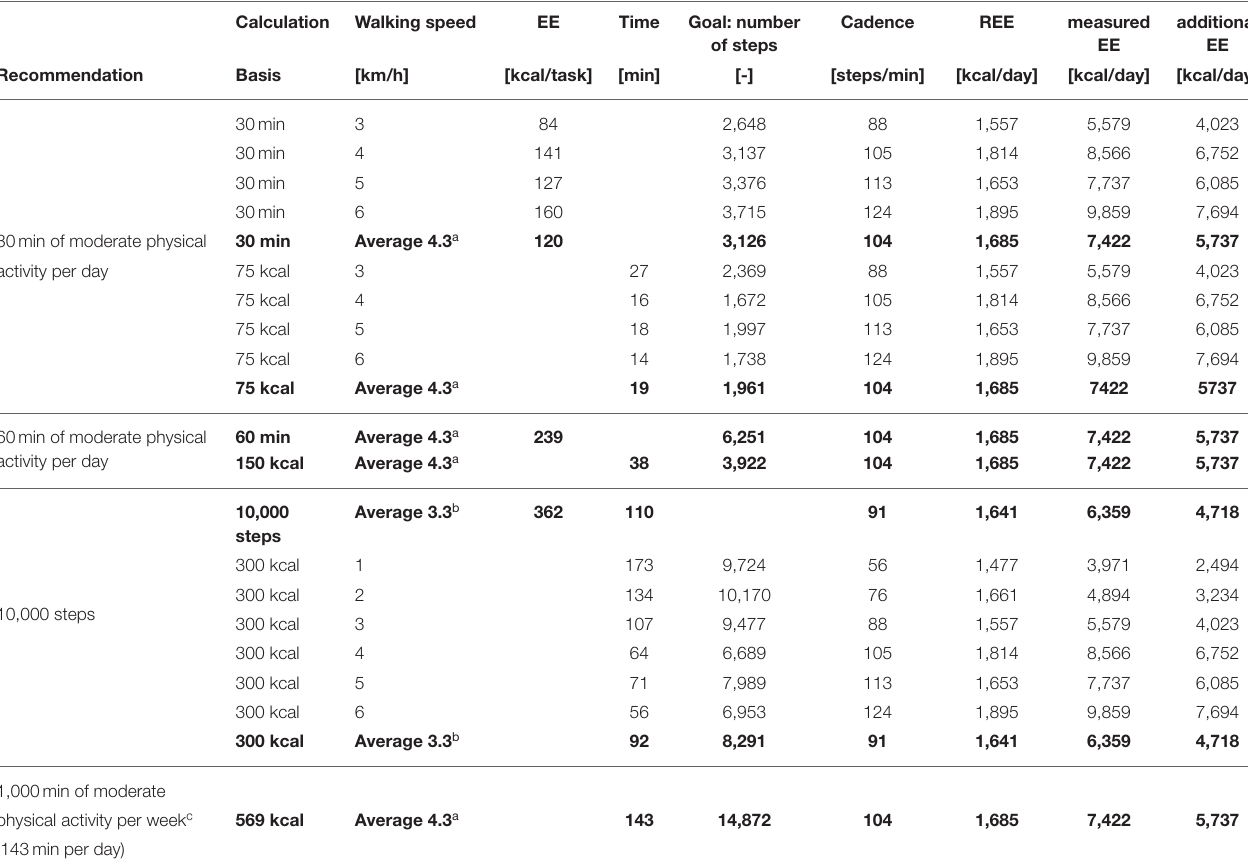
TABLE 5 | Translation of different activity guidelines and recommendation for the non-disabled population to daily step goals for ambulatory individuals with an incomplete spinal cord injury (iSCI).